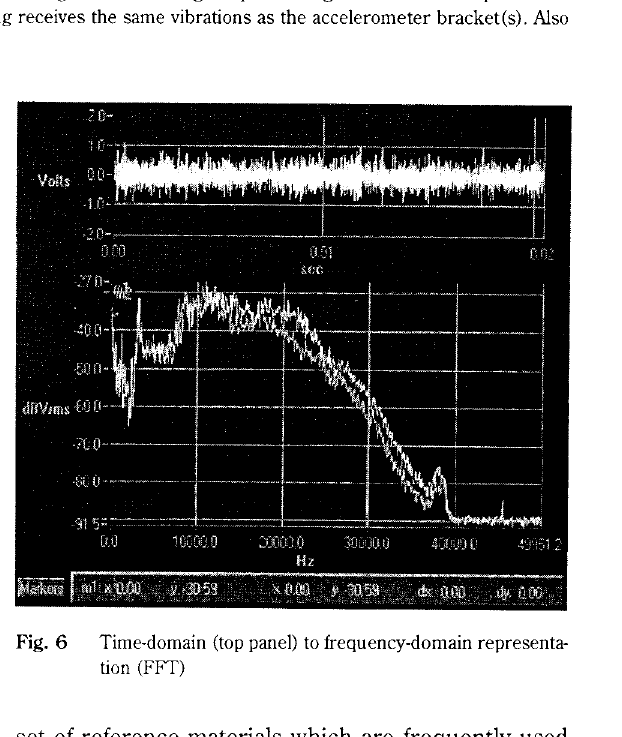
Details of accelerometer mounting (from left to right): bottom mounting- side mounting- top mounting. Note that it is imperative to affix cabling firmly to pipeline surface to ensure that the cabling receives the same vibrations as the accelerometer bracket(s). Also note bracket preparations on pipeline surface.